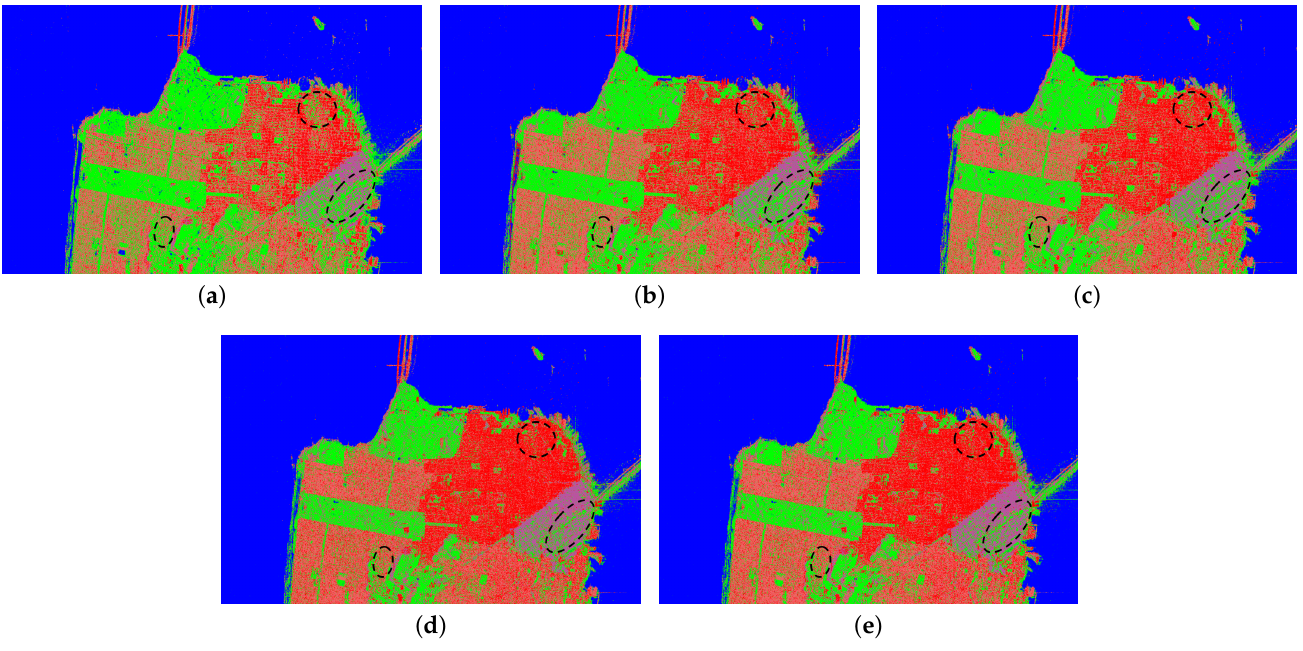
Figure 5. The ML-based classification maps of five models on the San Francisco region. ( a ) Wishart. ( b ) K-Wishart. ( c ) G. ( d ) WMM. ( e )